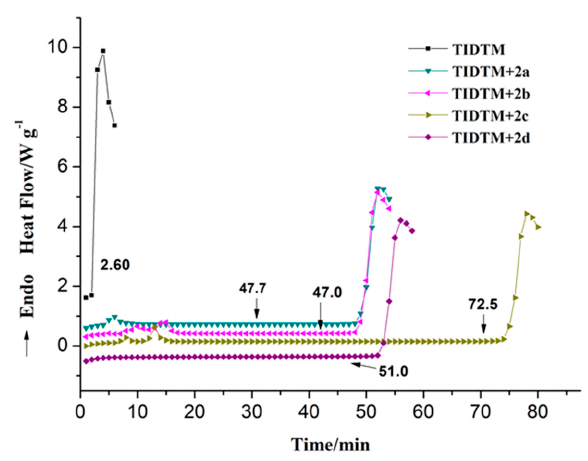
Figure 5. Oxidation induction time of TIDTM and TIDTM containing 1 wt % compounds 2a – d at 230 °C, respectively. 230 ◦ C,